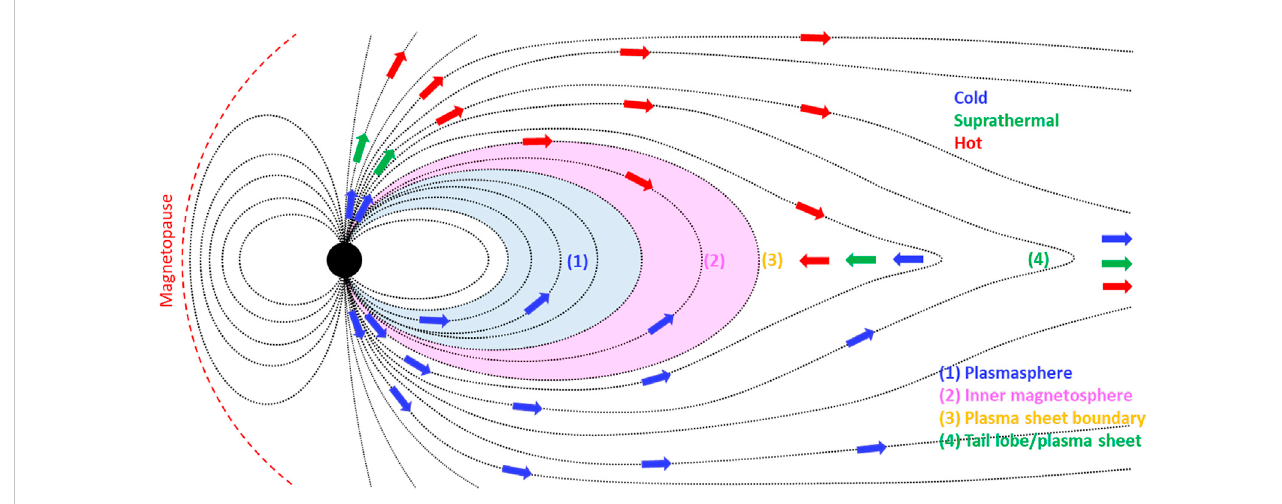
FIGURE 1 Schematic of the out fl owing ions classi fi ed by energy and destination, recreated from Yamauchi